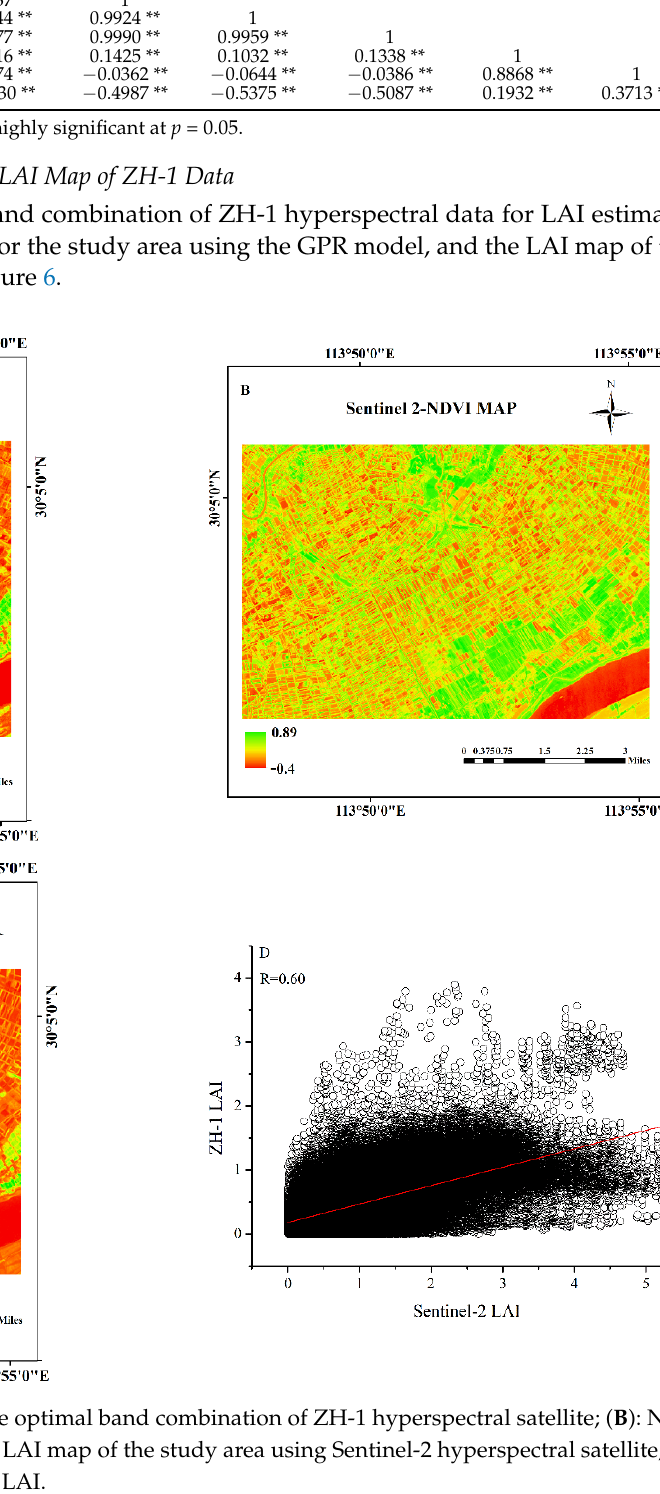
Table 5. Correlation between the optimal band combination and LAI.